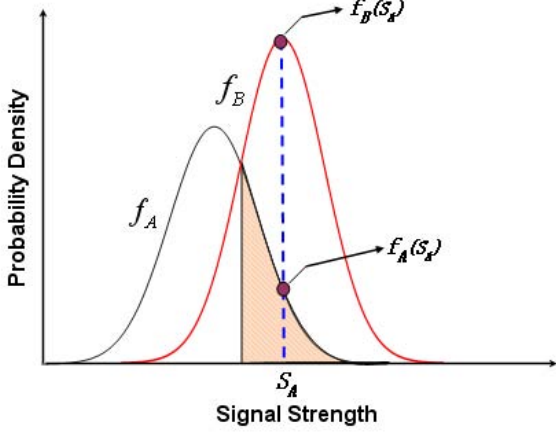
Figure 4. Probability density functions of RSSI received from beacon node A